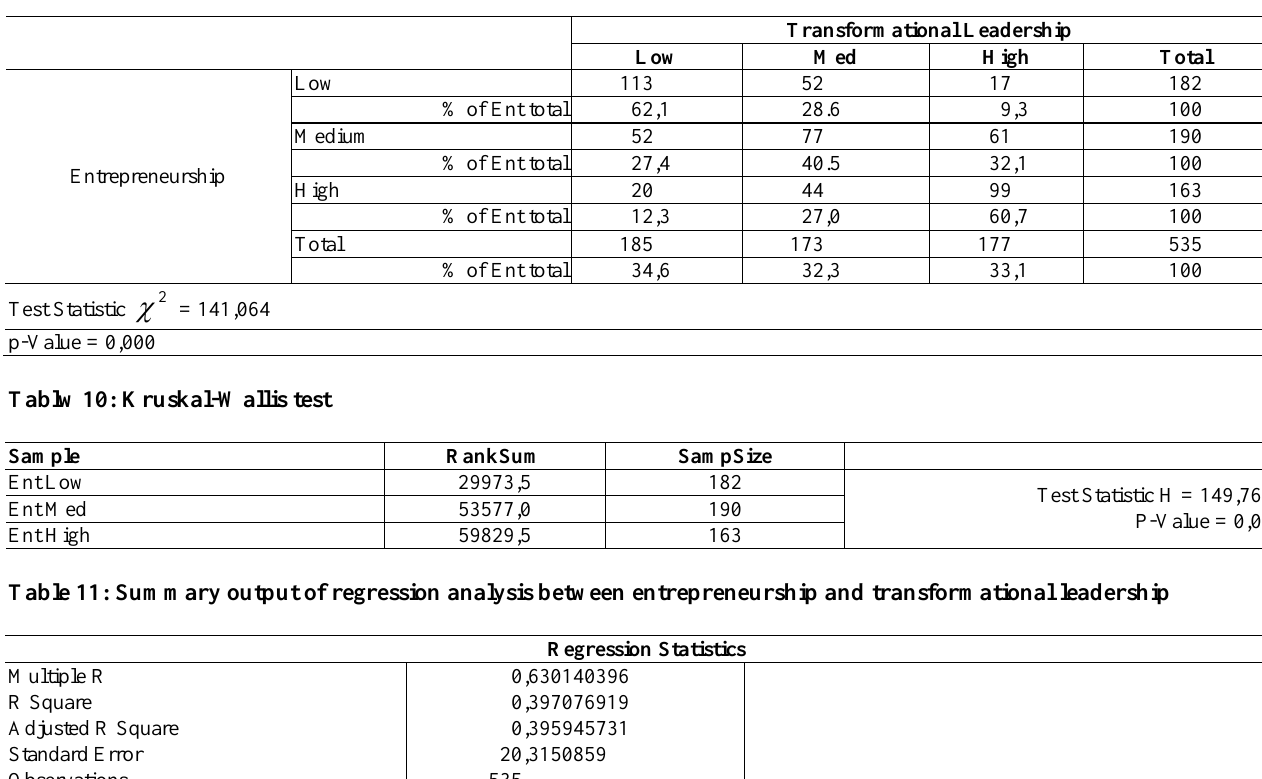
Table 9: Contingency table